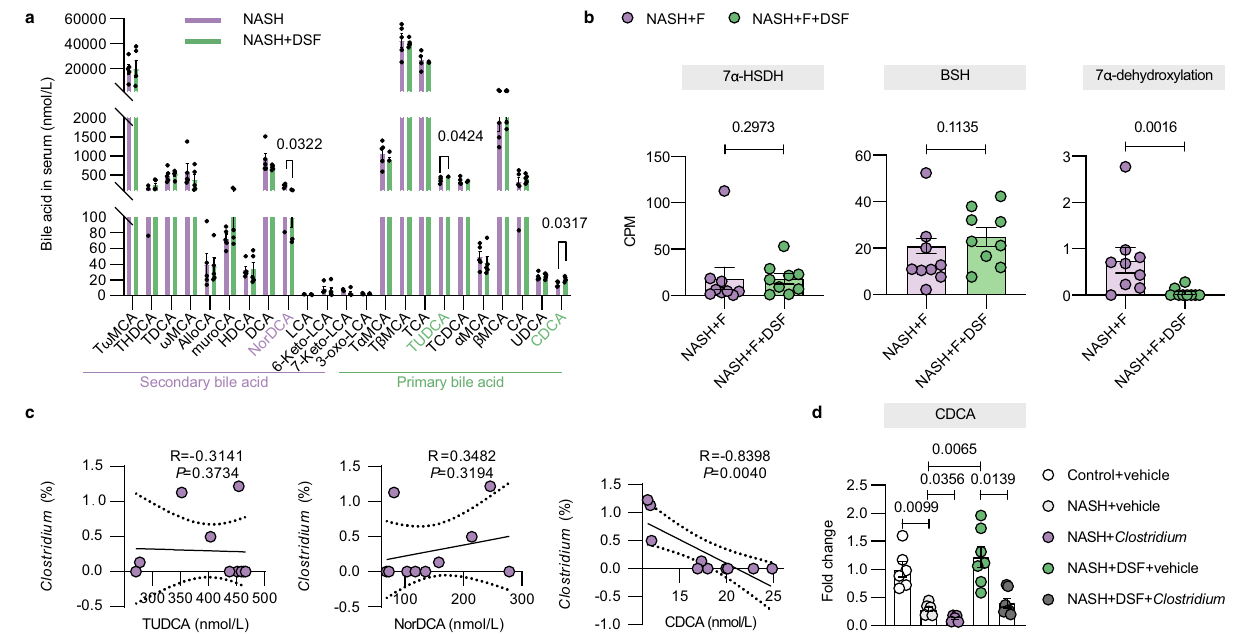
Fig. 4 | DSF reduces Clostridium -mediated 7 α -dehydroxylation activity to suppresssecondarybileacidbiosynthesis.a Bileacidlevelsintheserumbetween NASH and NASH+DSF groups. n=5 individuals/group. b BSH activity, 7 α -HSDH activity and 7 α -dehydroxylation activity in NASH+F and NASH+F+DSF groups were pro fi led by EC number annotations. n =9 individuals/group. c The correla- tions between the abundance of Clostridium and TUDCA, NorDCA and CDCA concentrations were analyzed using Spearman ’ s correlation (two-sided). 5 mice each in NASHand NASH+DSFgroup wereincluded inthe statistics. d Foldchange oftheCDCAlevelinserumintheadministrationof Clostridium experiment. n =6/6/